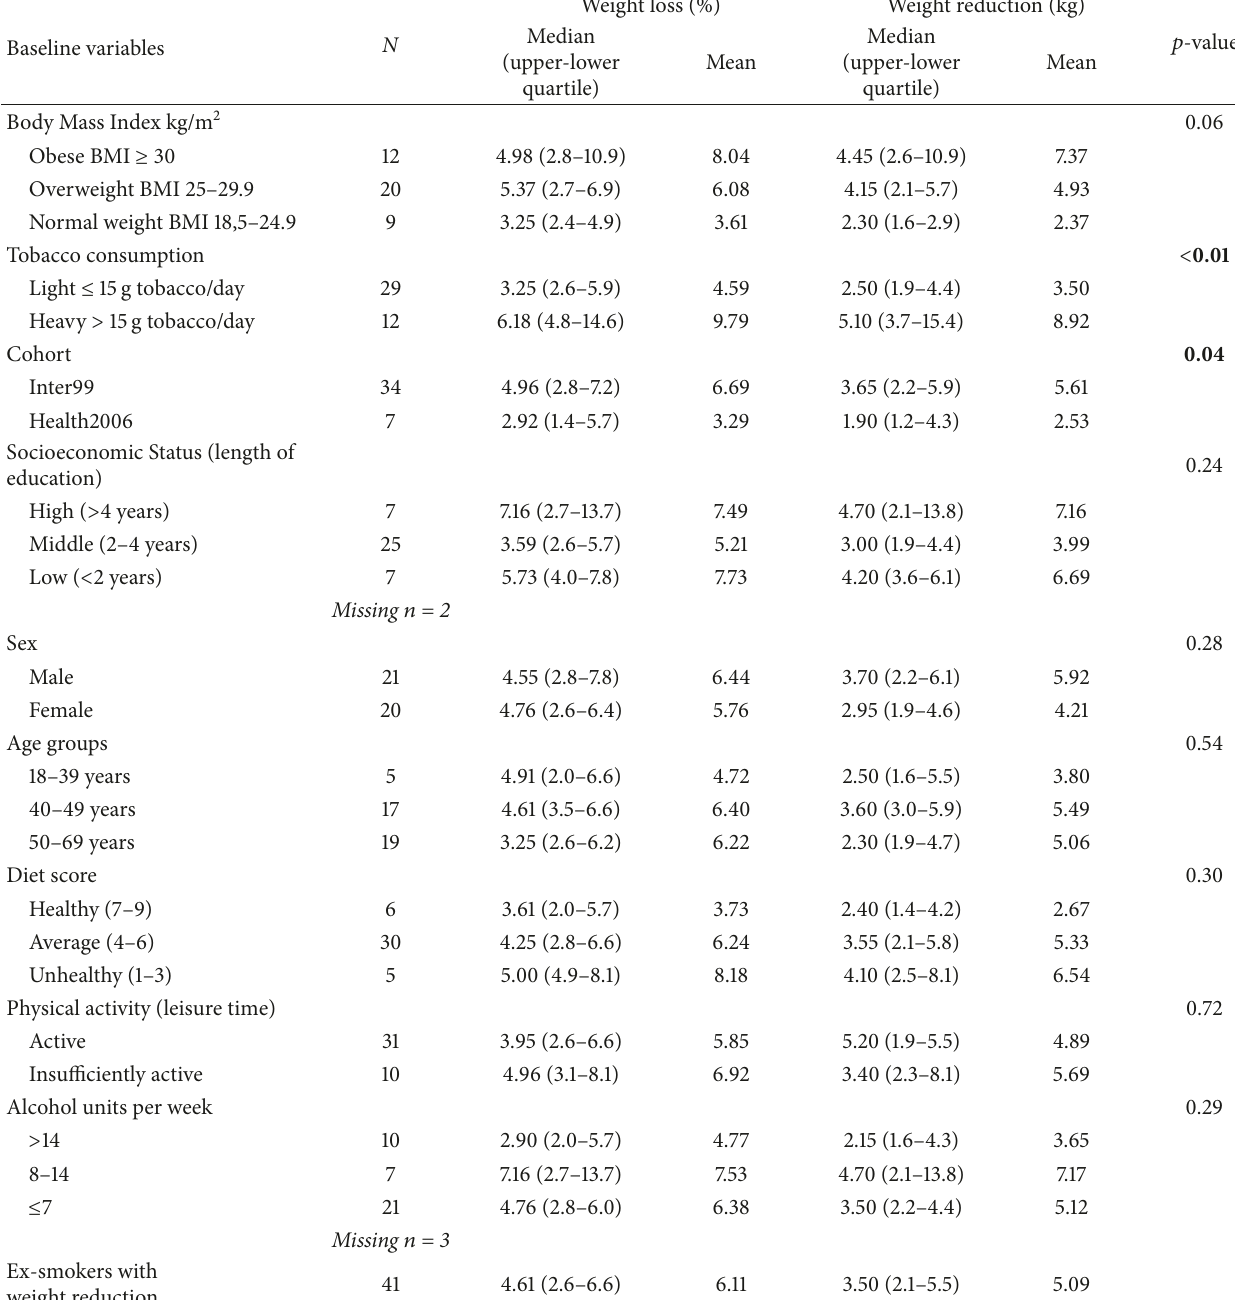
Table 2: Baseline characteristics of ex-smokers at five year follow-up with a weight reduction of minimum 1 kg ( 𝑁 = 41